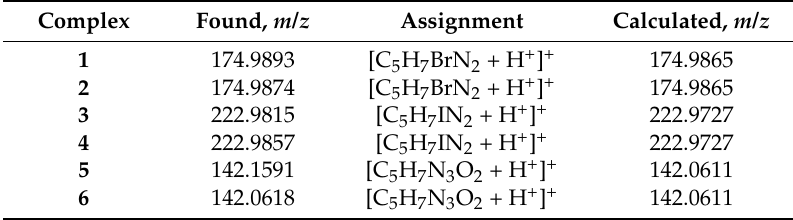
Table 1. Most populated peaks and their assignments from the mass spectrometry analysis of complexes 1 – 6